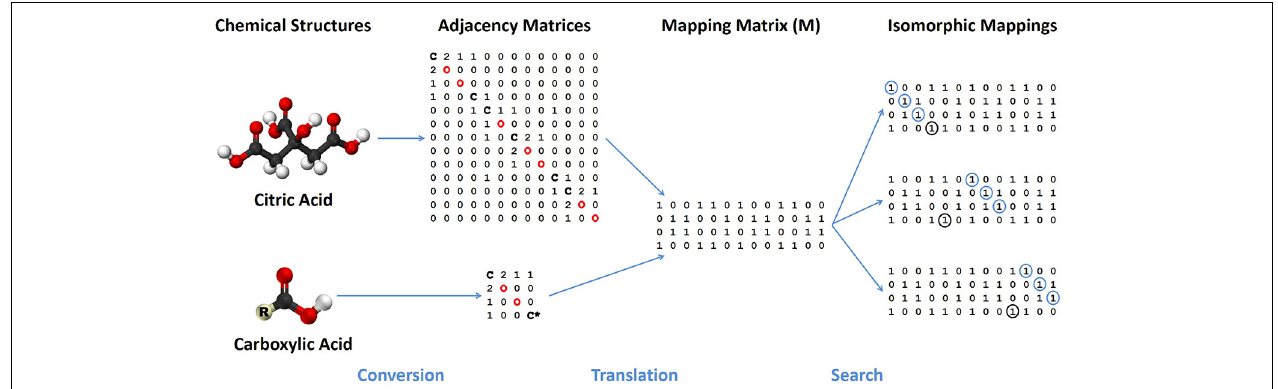
FIGURE 3 | Flowchart of major steps and representations needed by a chemical substructure search algorithm. Chemical structures of a specific compound and functional group are treated as colored graphs that are converted into adjacency matrices with elements identified along the